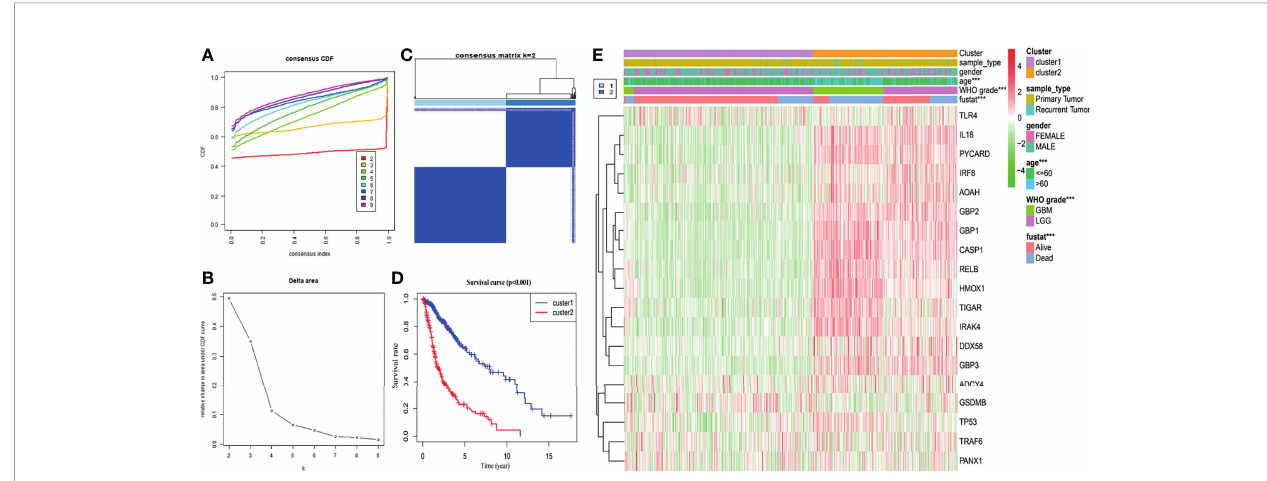
FIGURE 2 | Glioma classi fi cation with differential OS and clinicopathological features in the TCGA dataset. (A) Cumulative distribution function of consensus clustering for k = 2 to 9. (B) The variation in area under the CDF curve for k = 2 to 9. (C) The consensus clustering matrix showed that the 670 glioma patients from the TCGA dataset were classi fi ed into two clusters (k = 2). (D) The Kaplan – Meier OS curves of cluster 1/2. (E) Differential clinicopathologic features and nineteen pyroptosis-related gene expression levels between cluster 1 and cluster 2. *** p <